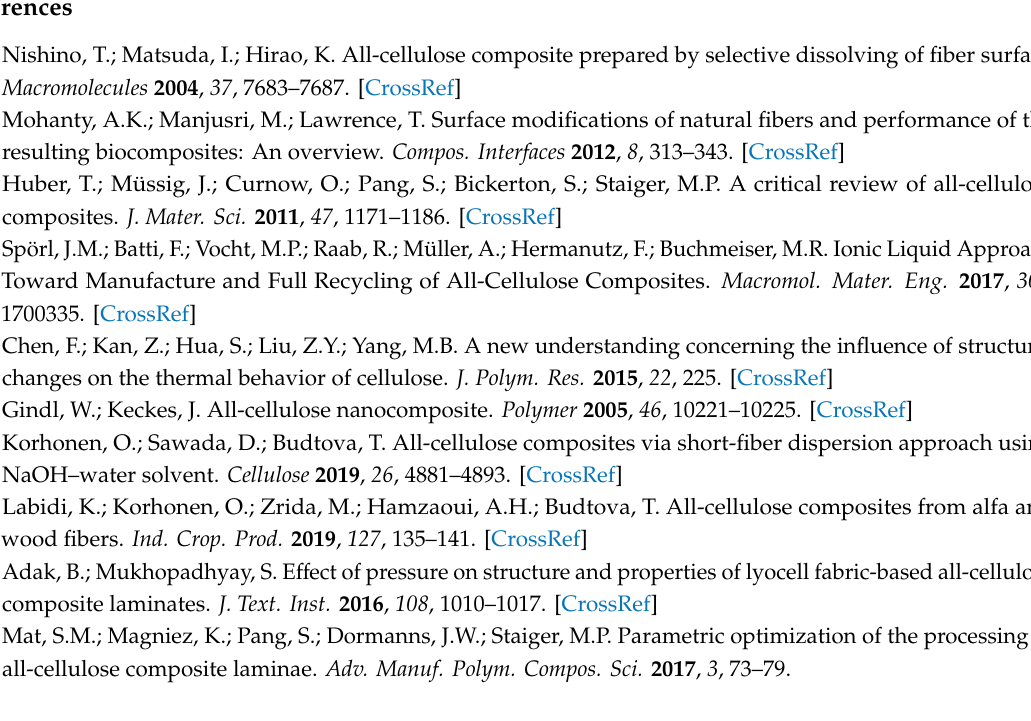
Figure S1: Representative stress-strain curve of a single flax fiber, Figure S2: Arrhenius plot of dissolution rate as a function of inverse temperature, Figure S3: Representative stress-strain curve of flax-based ACCs after 45 min impregnation tested in transverse direction, Table S1: Properties of flax based